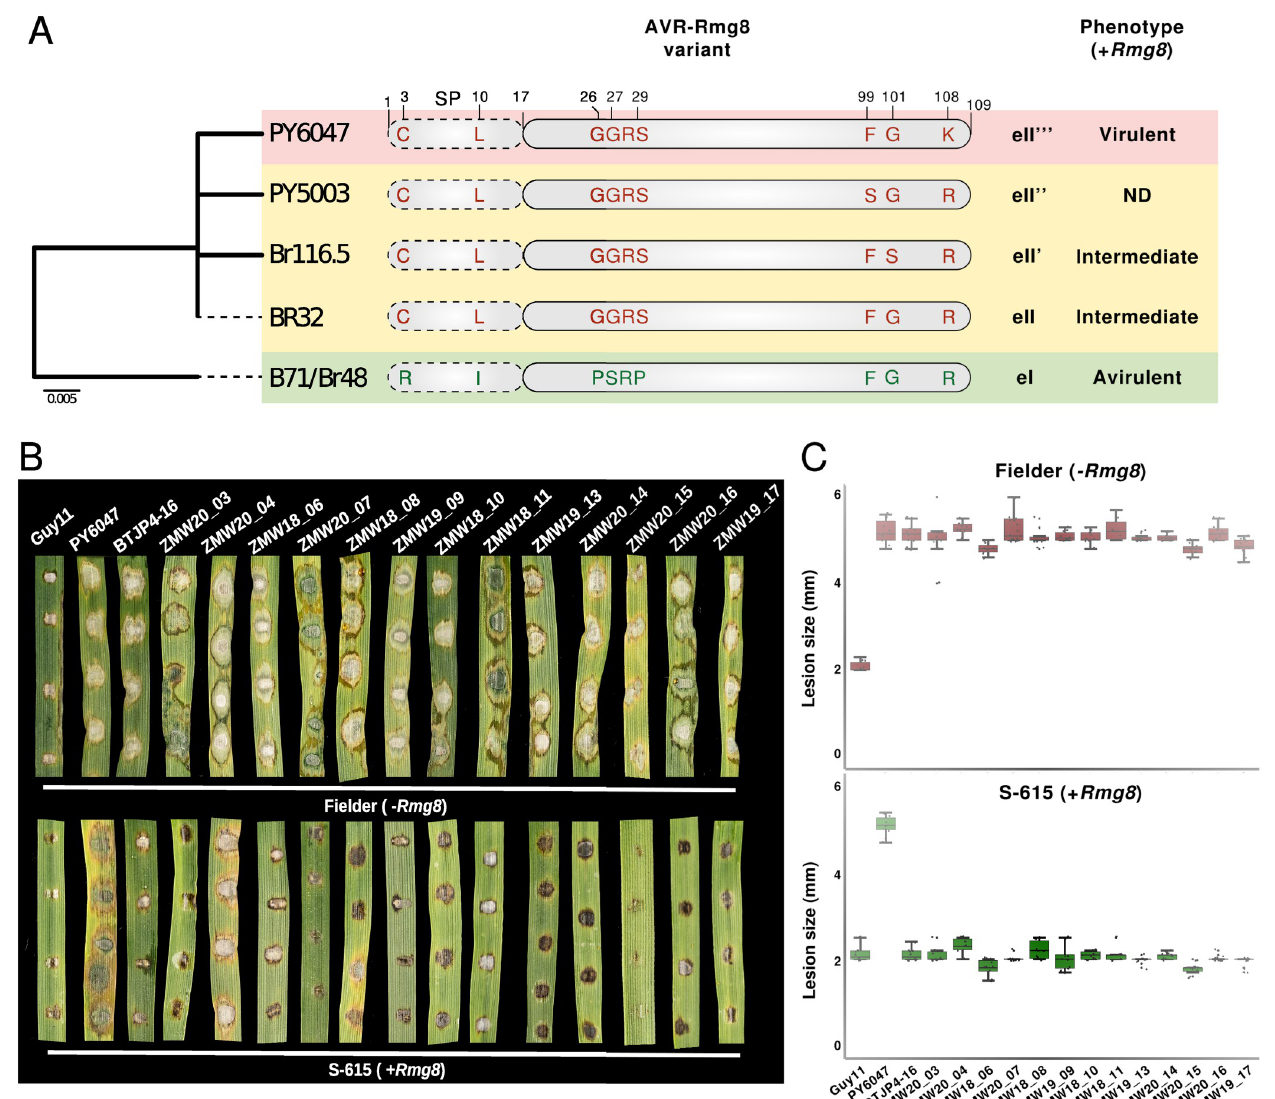
Fig 3. Rmg8 confers resistance against Zambian wheat blast isolates. (A) The wheat blast lineage contains 5 AVR-Rmg8 variants. Neighbor-joining tree based on amino acid sequences of all nonredundant AVR-Rmg8 variants of 71 wheat blast lineage isolates (left). Representative isolate IDs are shown for each branch. Schematic representation of polymorphic amino acids in AVR-Rmg8 variants of the wheat blast lineage (center). Virulence phenotype associated with each AVR-Rmg8 variant on Rmg8 containing host plants (right). (B) The resistance gene Rmg8 is effective against wheat blast isolates collected in Zambia. Leaves from two weeks old seedlings of Fielder (- Rmg8 , upper panel) and S-165 (+ Rmg8 , lower panel) wheat cultivars were inoculated with spores from Zambian wheat blast isolates, the rice blast isolate Guy11 (non-adapted, avirulent control), PY6047 (virulent control; AVR-Rmg8 eII”‘- carrier), and BTJP4-16 (avirulent on Rmg8 carrying host plants, AVR-Rmg8 eI carrier). Disease and lesion size 5 days’ post-infection. Photo taken by the authors. (C) Quantification of lesions size (in mm) of 10 leaves and three independent experiments. The data underlying this figure can be found in https://